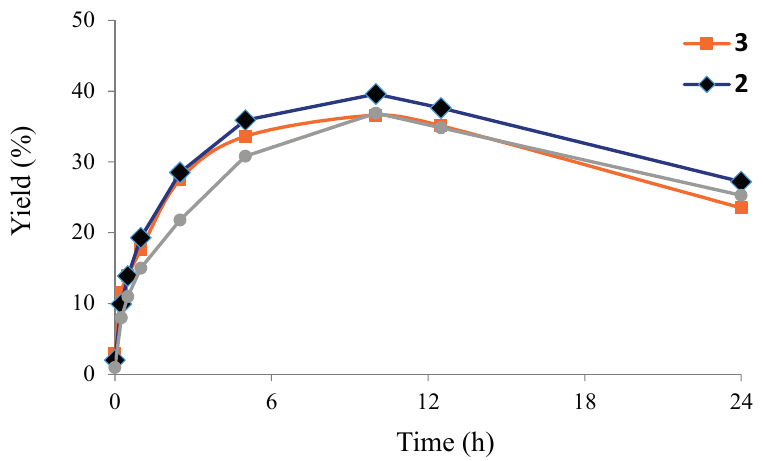
Figure 3. Dependence of the overall yield (mol %, based on substrate) of the products (cyclohexanol + cyclohexanone) on the reaction time, for the oxidation of cyclohexane. Reaction conditions: cyclohexane (5.0 mmol), 5.0 μ mol of 1 (  ), 2 ( ♦ ) or 3 (  ), n (H 2 O 2 )/ n (catalyst) (2 × 10 3 ),